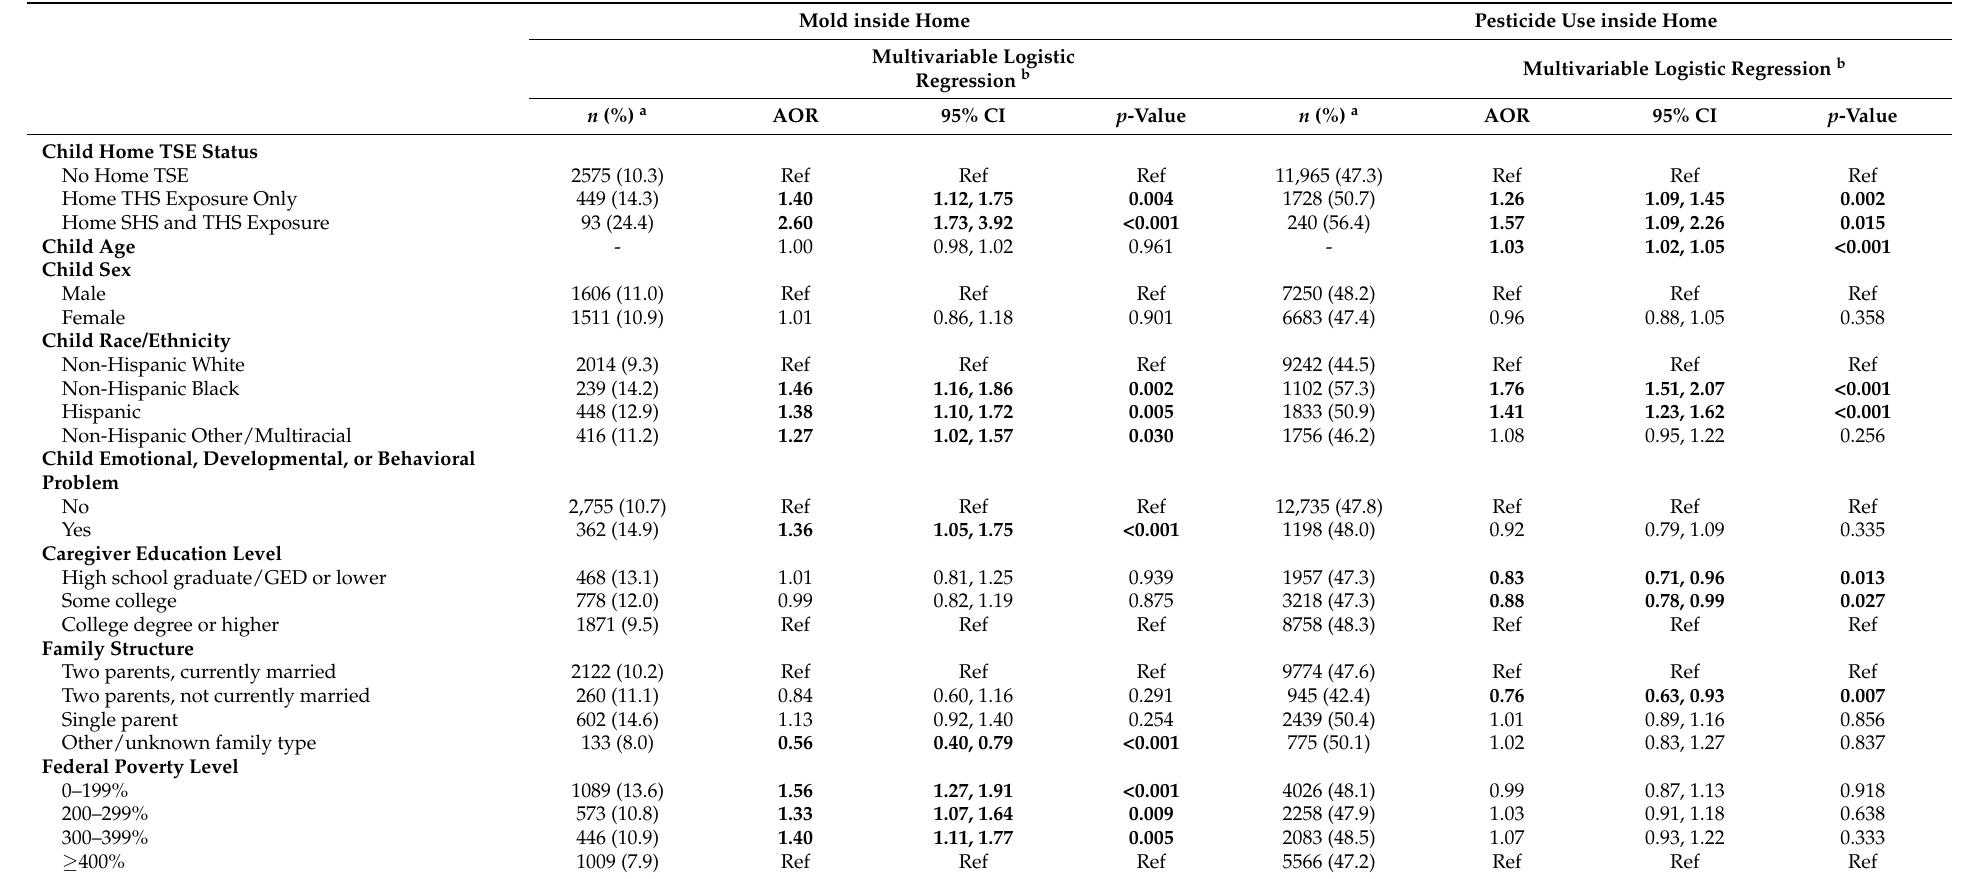
Abbreviations: TSE, tobacco smoke exposure; THS, thirdhand smoke; SHS, secondhand smoke; Ref, reference category. a Raw counts and weighted row percents. b Multivariable logistic regression models including all